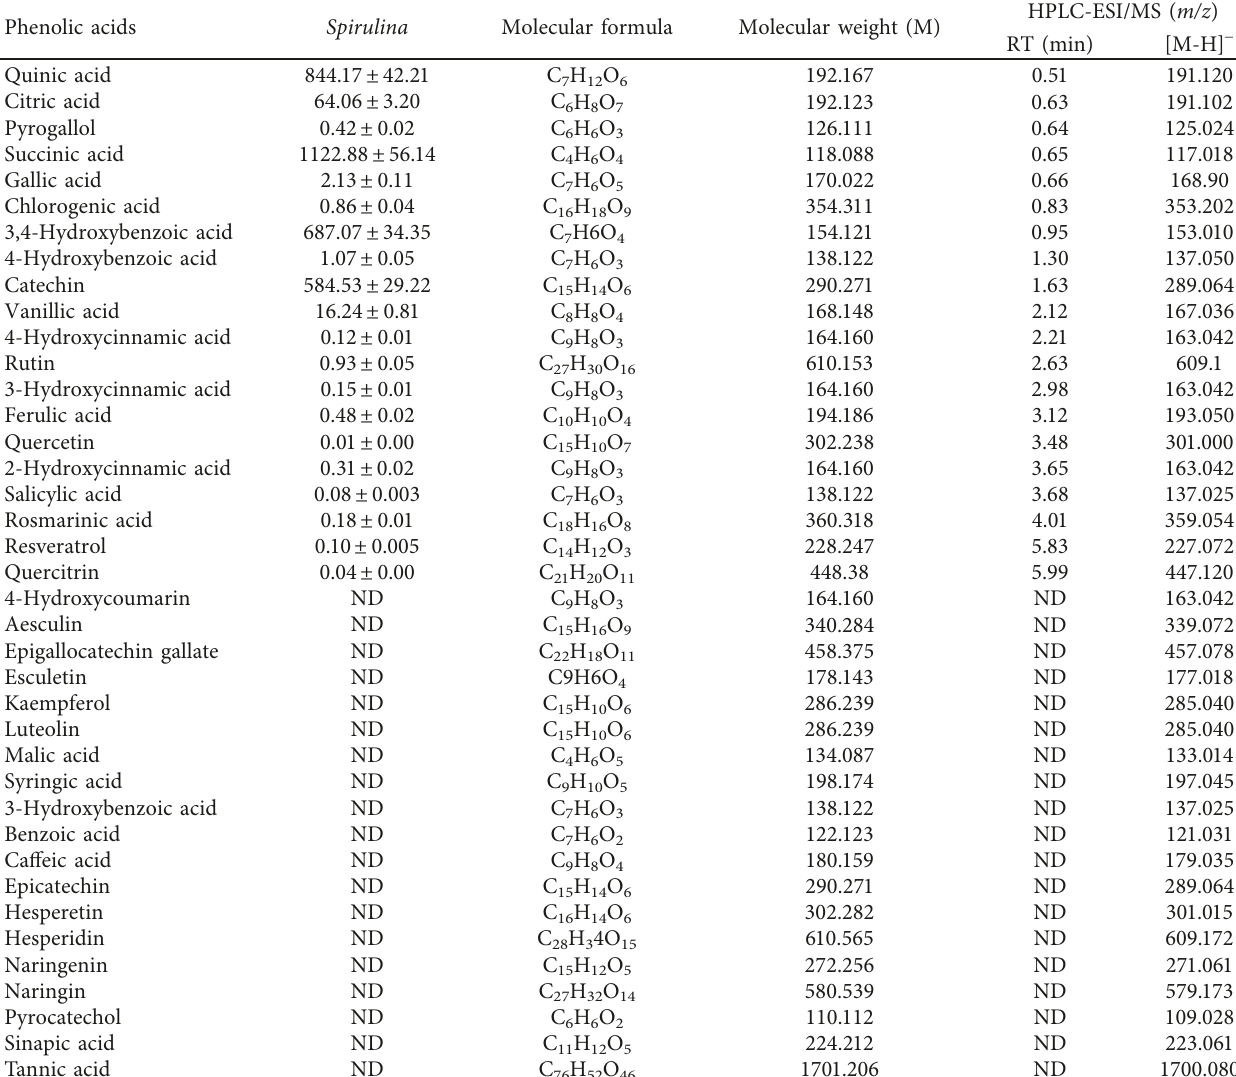
Table 4: Phenolic and flavonoid compounds determined in the Spirulina -evaluated samples